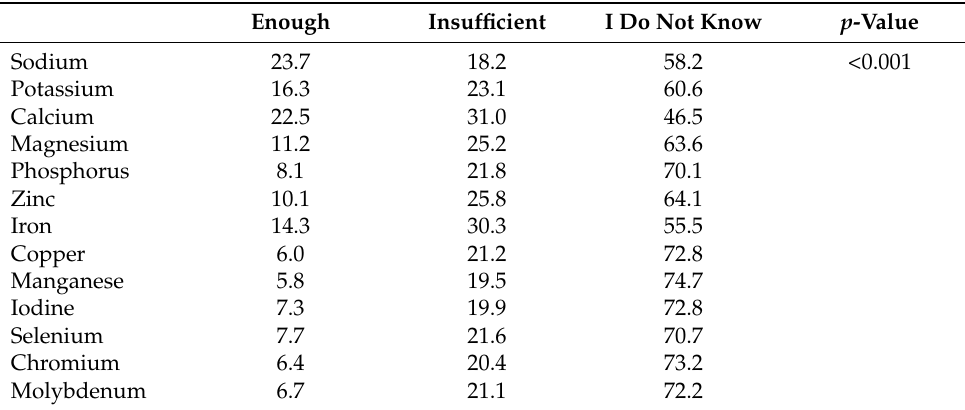
Table 8. The perception of one’s mineral intake